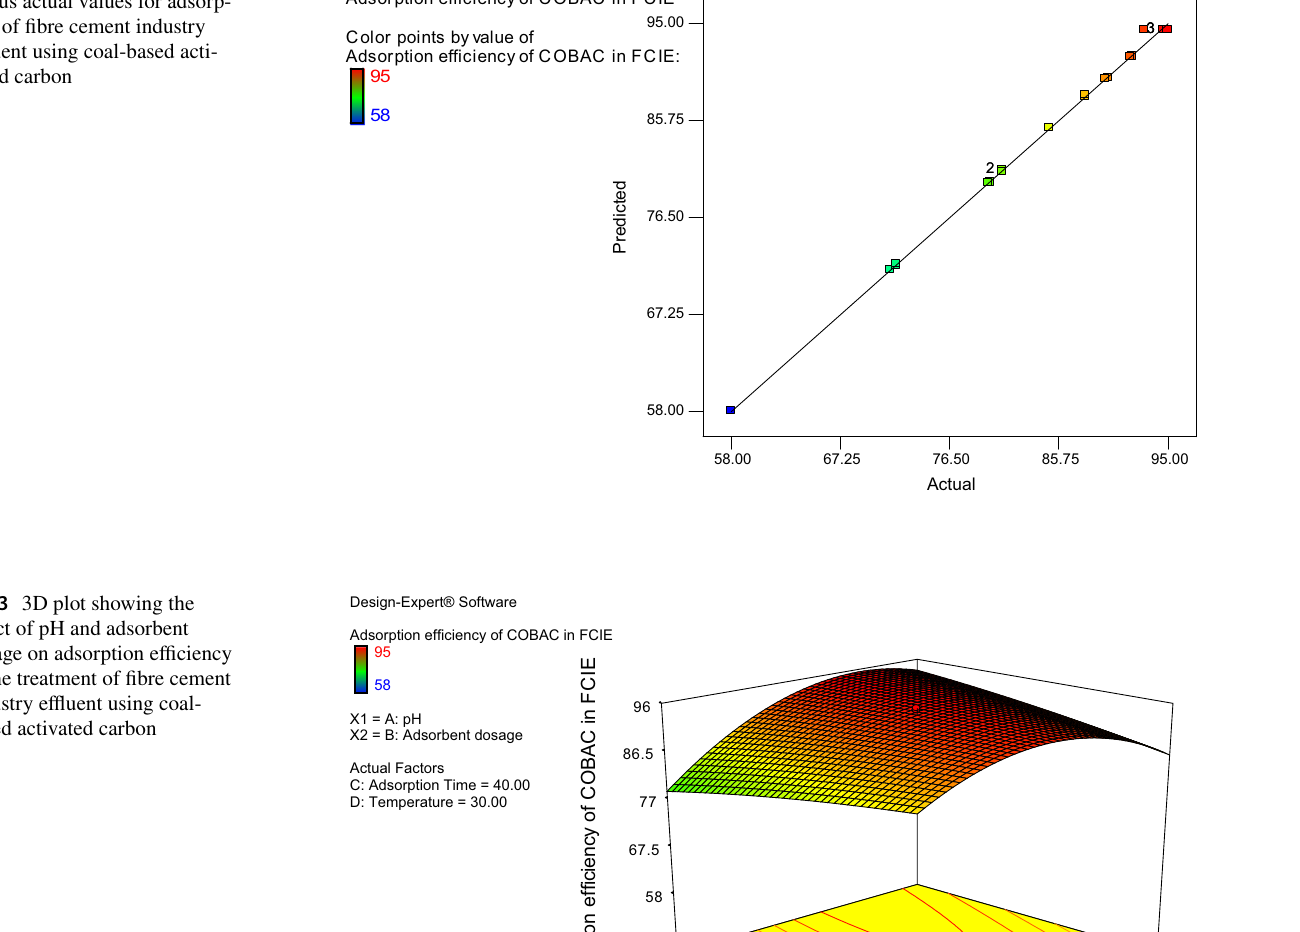
Fig. 2 Plot of predicted values versus actual values for adsorp- tion of fibre cement industry